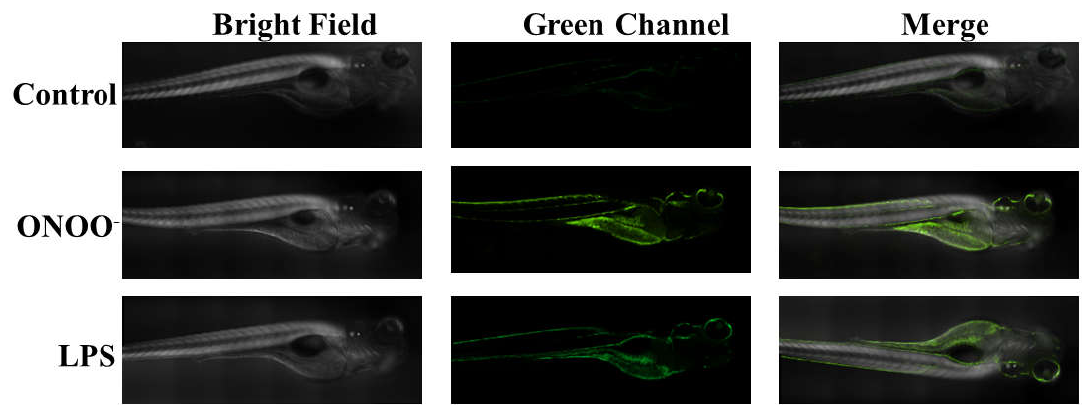
Figure 7. Bright-field and fluorescence imaging of exogenous and endogenous ONOO − generation in zebrafish by using HDBT-ONOO − as the probe. λ ex = 450 nm.